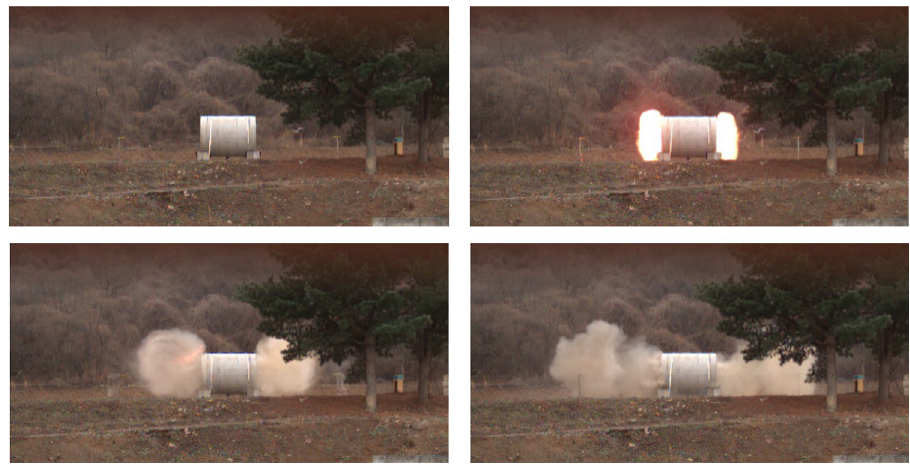
Figure 7. Energy release photos of ANFO 15.88 kg.